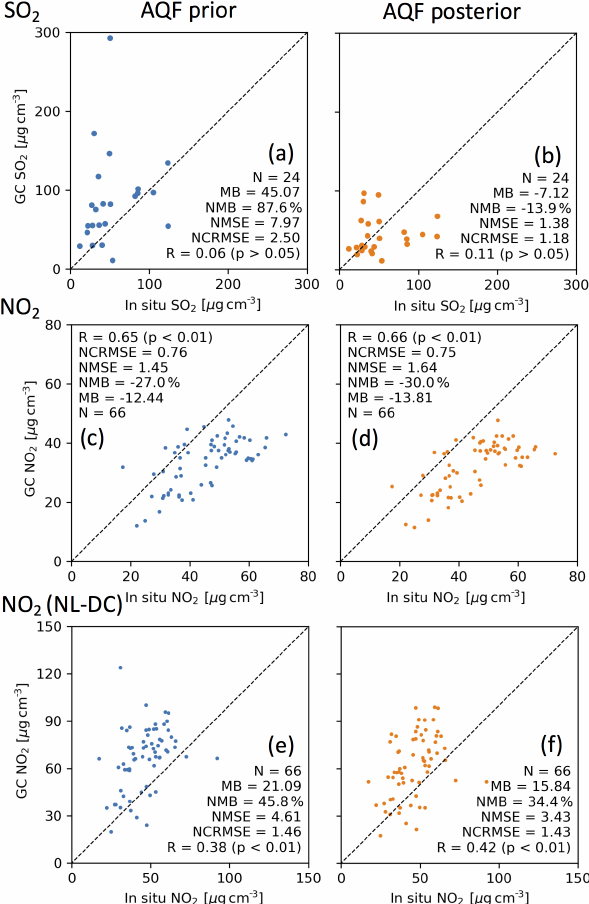
Figure 12. Evaluation of GEOS-Chem surface SO 2 and NO 2 fore- casts with in situ observations for November 2013. Panels (a) and (b) show scatter plots of AQF-PRI and AQF-MIX-DE-POS SO 2 at 0 . 25 ◦ × 0 . 3125 ◦ versus in situ province-capital-city observations, respectively. Panels (c) and (d) show scatter plots of AQF-PRI and AQF-MIX-DE-POS NO 2 at 0 . 25 ◦ × 0 . 3125 ◦ versus in situ observa- tions, respectively. Panels (e) and (f) show scatter plots of AQF-NL- DC-PRI and AQF-NL-DC-POS NO 2 at 0 . 05 ◦ × 0 . 05 ◦ versus in situ observations, respectively. The linear correlation coefficient ( R ), normalized centered root mean squared error (NCRMSE), normal- ized mean squared error (NMSE), normalized mean bias (NMB), mean bias (MB), and number of observations ( N ) are shown over scatter